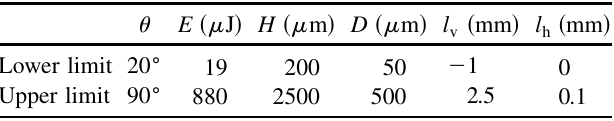
(1H,1H,2H,2H-Perfluorooctyltrichlorosilane) to pin the TABLE I. The range of control parameters for the initial con- tact angle of the liquid with the glass capillary (cid:2) , the distance between the meniscus and the laser focus position H ; the absorbed laser energy E ; the focus offset of the laser in the ; and the focus offset of the laser in the hori- vertical plane l v . The inner diameters of capillary tubes D are 50, zontal plane l h 200, and 500 (cid:1) m